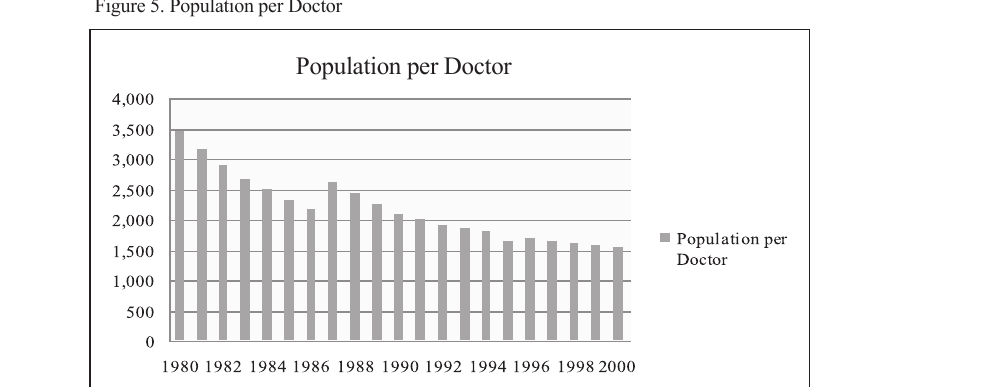
Figure 5. Population per Doctor Population per Doctor